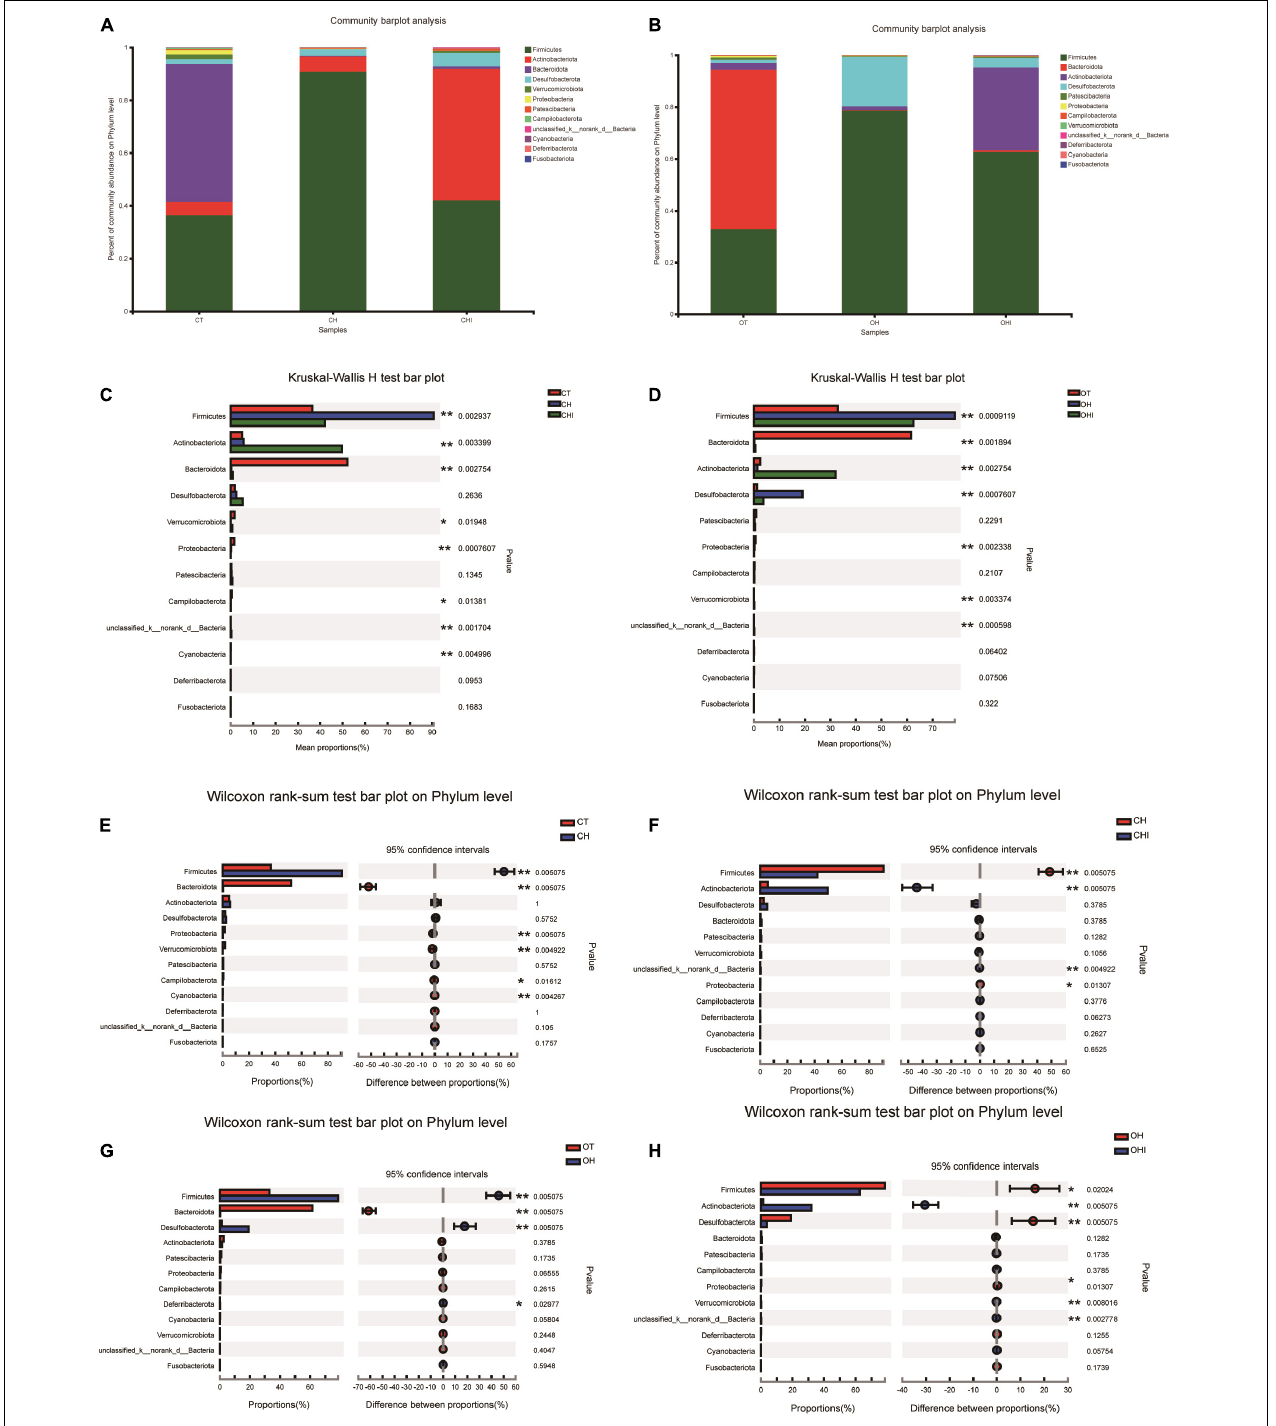
FIGURE 3 | Relative abundance of cecal microbiota in phylum level. (A) Relative abundance of cecal microbiota for CT, CH, and CHI groups on phylum level. (B) Relative abundance of cecal microbiota for OT, OH, and OHI groups on phylum level. (C) The cecal microbiota showed differential abundance at the phylum level between the CT, CH, and CHI groups. (D) The cecal microbiota showed differential abundance at the phylum level between the OT, OH, and OHI groups. (E) The cecal microbiota showed differential abundance at the phylum level between the CT and CH groups according to t -tests. (F) The cecal microbiota showed differential abundance at the phylum level between the CH and CHI groups according to t -tests. (G) The cecal microbiota showed differential abundance at the phylum level between the OT and OH groups according to t -tests. (H) The cecal microbiota showed differential abundance at the phylum level between the OH and OHI groups according to t -tests. *Indicated there was a significant difference compared with OT ( p < 0.05), ** indicated there was a significant difference compared with OT ( p < 0.01).